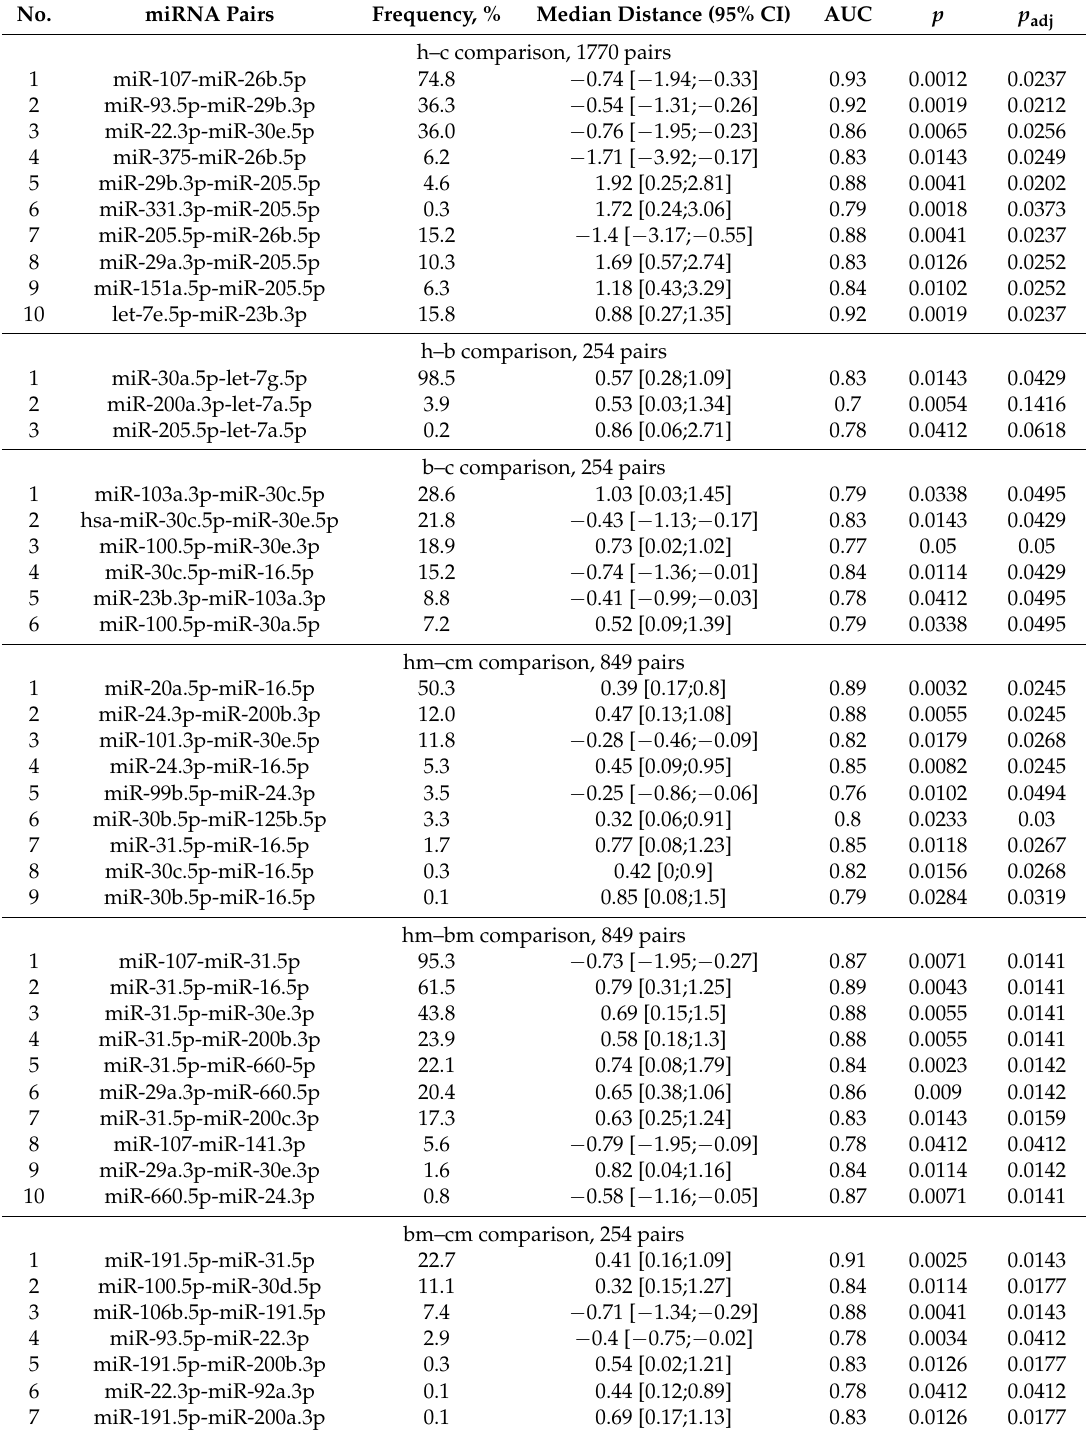
Table 1. Significant predictors of group